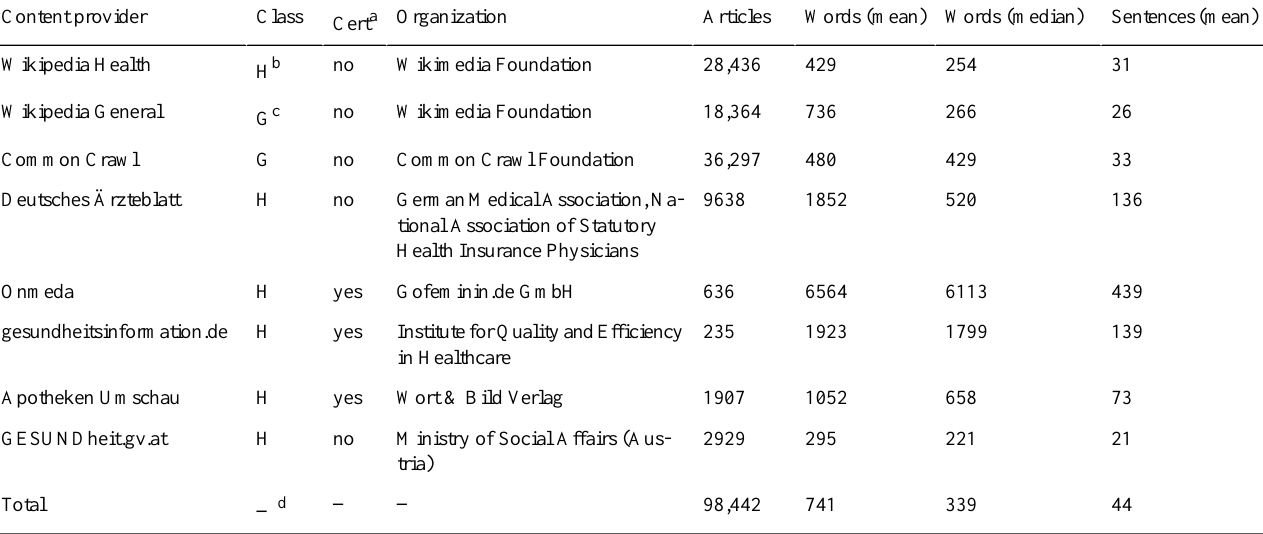
Table 1. Total number of acquired articles and respective class labels of various German content